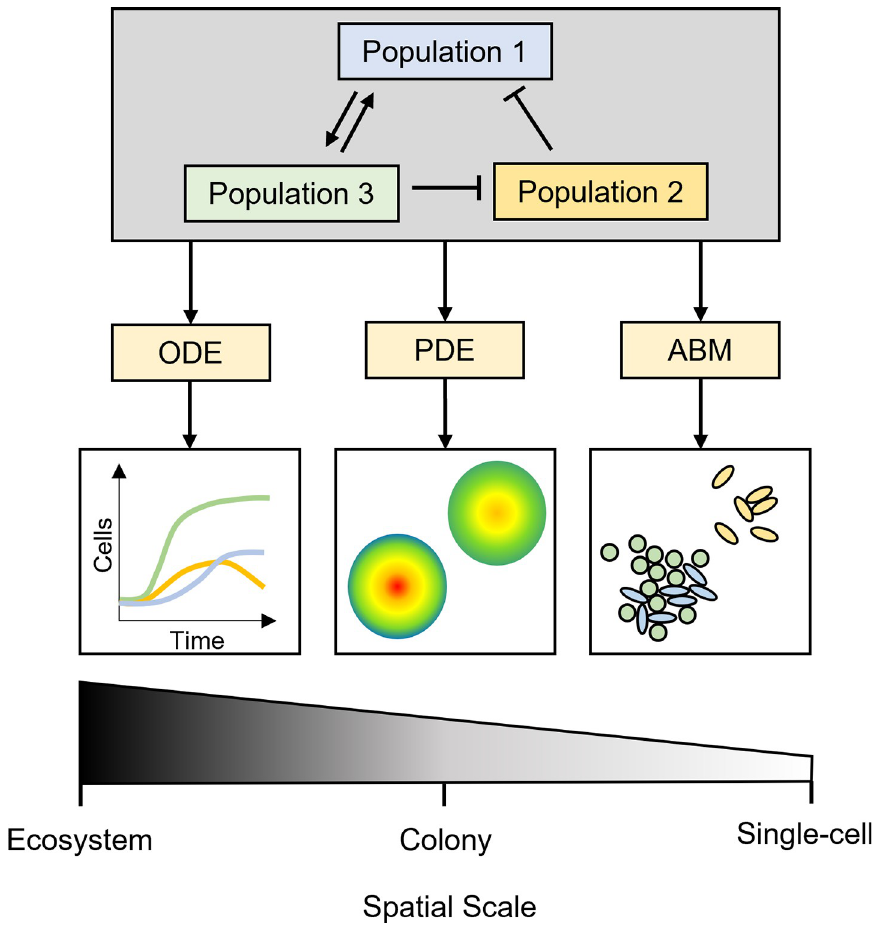
Fig 1. Modelling frameworks commonly used for capturing the behaviour of microbial communities, with associated spatial scales. ABM, agent-based model; ODE, ordinary differential equation; PDE, partial differential